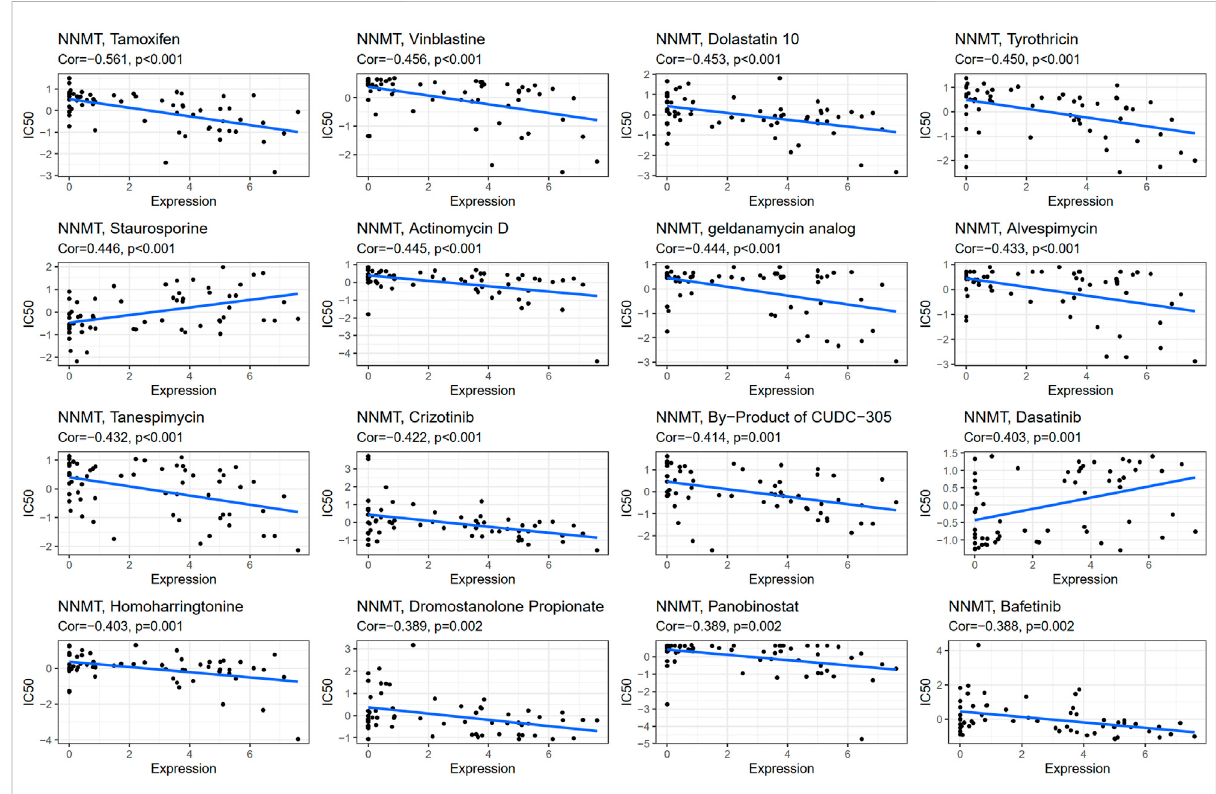
FIGURE 11 A depiction of the association between NNMT expression and predicted FDA drug